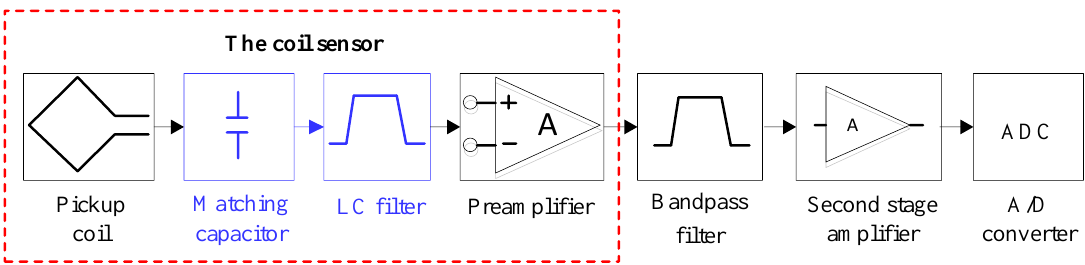
Figure 4. The new MRS data acquisition system.